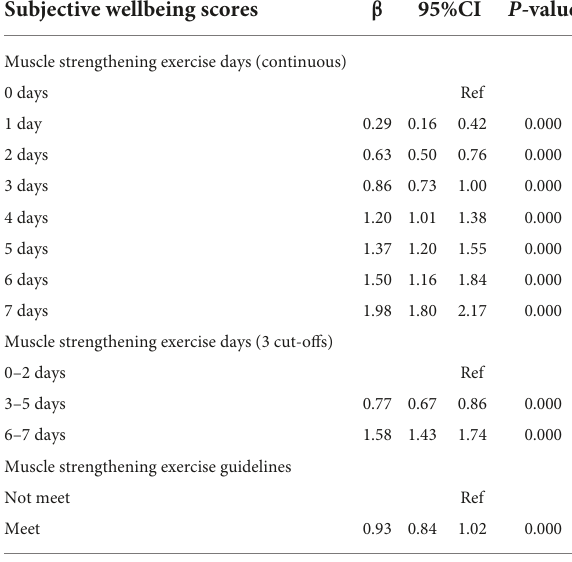
TABLE 1 Sample characteristics in this study. TABLE 2 Results for the associations between muscle strengthening exercise and subjective wellbeing scores.